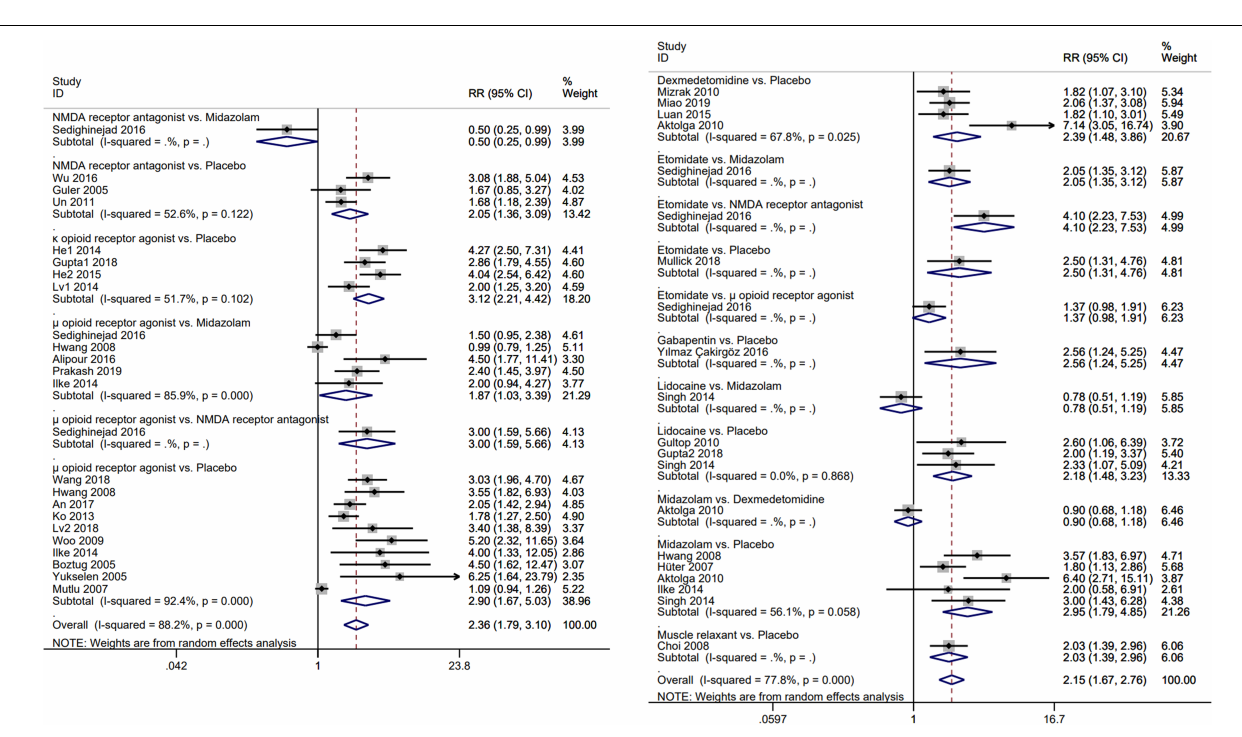
FIGURE 3 | Forest plot for direct comparison of each pair of interventions. Meta-analysis use RR and 95%CI for the incidence of etomidate-induced myoclonus. RR , risk ratio; CI , confidence interval.